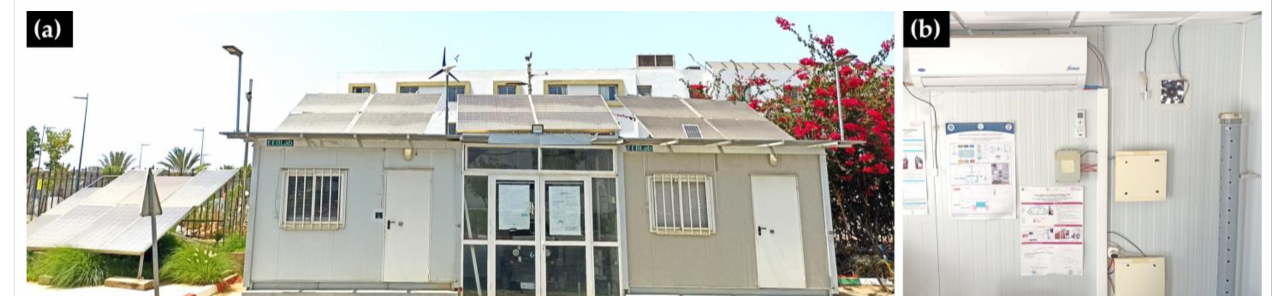
Figure 1. ( a ) Energy Efficient Building Lab (EEBLab) test site; ( b ) Interior side wall of EEBLab with